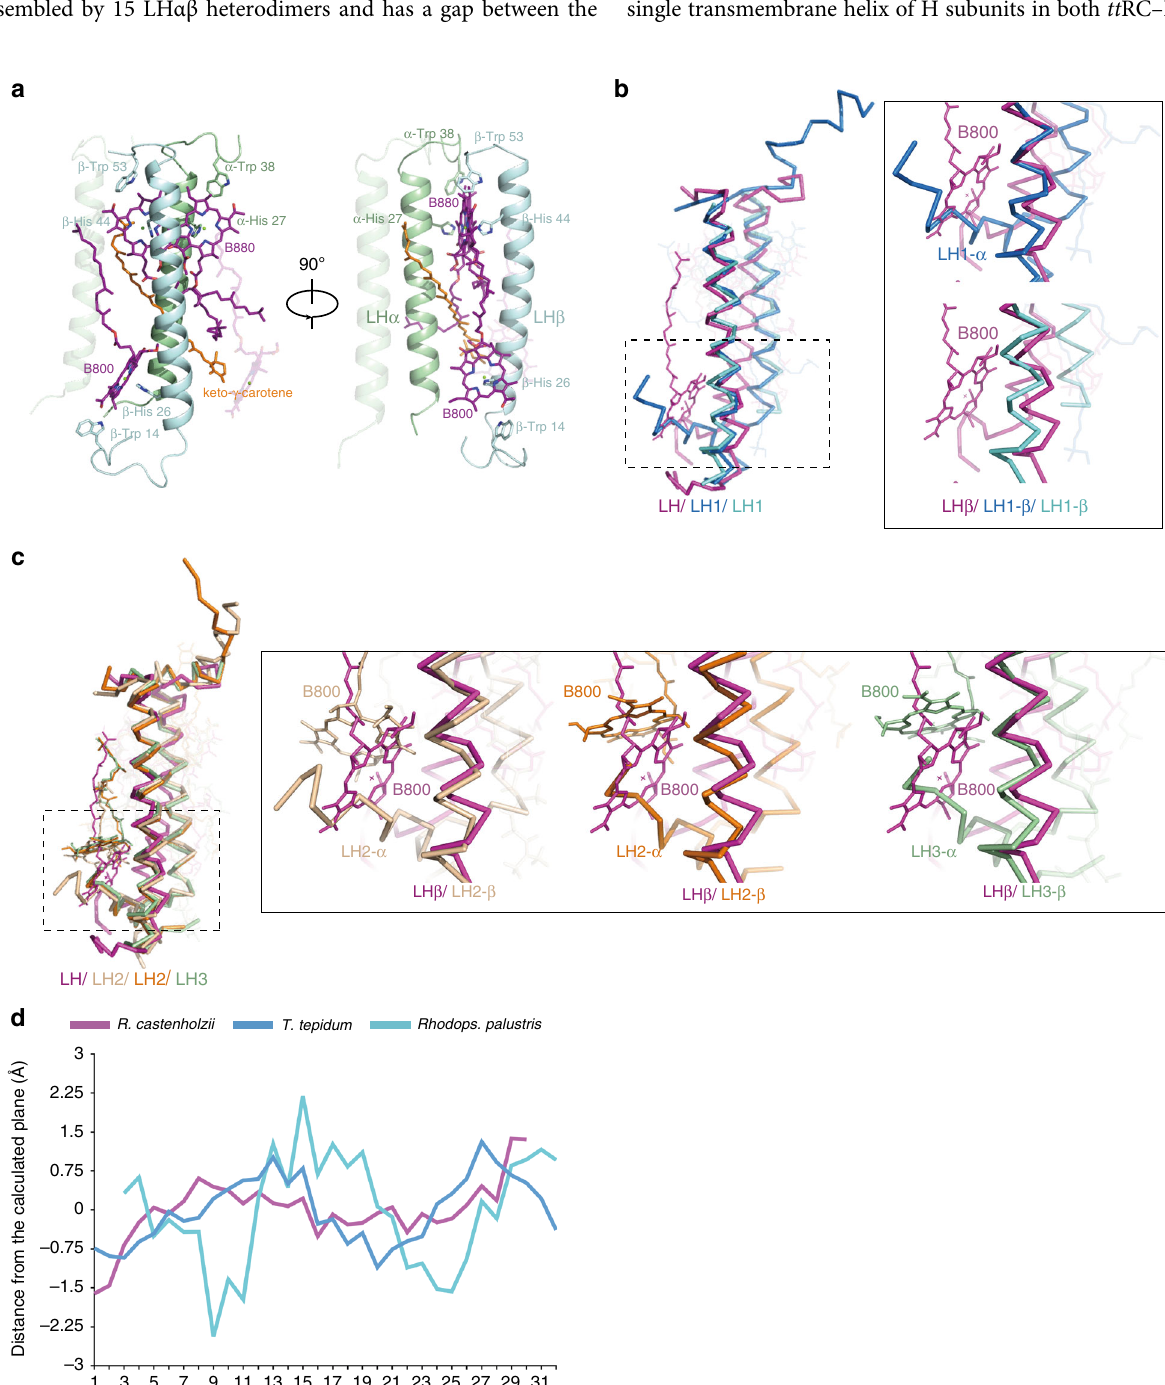
Fig. 3 Structure of the light-harvesting antenna. a Two side views with 90° increment presenting an LH αβ -heterodimer of R. castenholzii with cofactors. The neighboring α -apoprotein and B800 are shown with 70% transparency. The BChls (purple), keto- γ -carotene molecules (orange), and their coordinating residues are shown in sticks. b An LH αβ -heterodimer of R. castenholzii (purple) is compared with the LH1 of T. tepidum (blue, accession code 3WMM) and Rhodops. palustris (cyan, accession code 1PYH). A zoom-in view of the B800 coordination is shown in the inset. c An LH αβ -heterodimer of R. castenholzii (purple) is compared with the LH2 of Rhodospirillum molischianum (wheat, accession code 1LGH) and LH2 (orange, accession code 1NKZ) and LH3 (pale green, accession code 1IJD) of Rhodopseudomonas acidophila . The inset shows a zoom-in view of the B800 coordination. d The distances between each B880 pigment and the central plane of B880 pigments ring-array are calculated and plotted to show the planarity of the B880 pigment arrangement for different core complexes, rc RC – LH (purple), tt RC – LH1 (blue), and rp RC – LH1